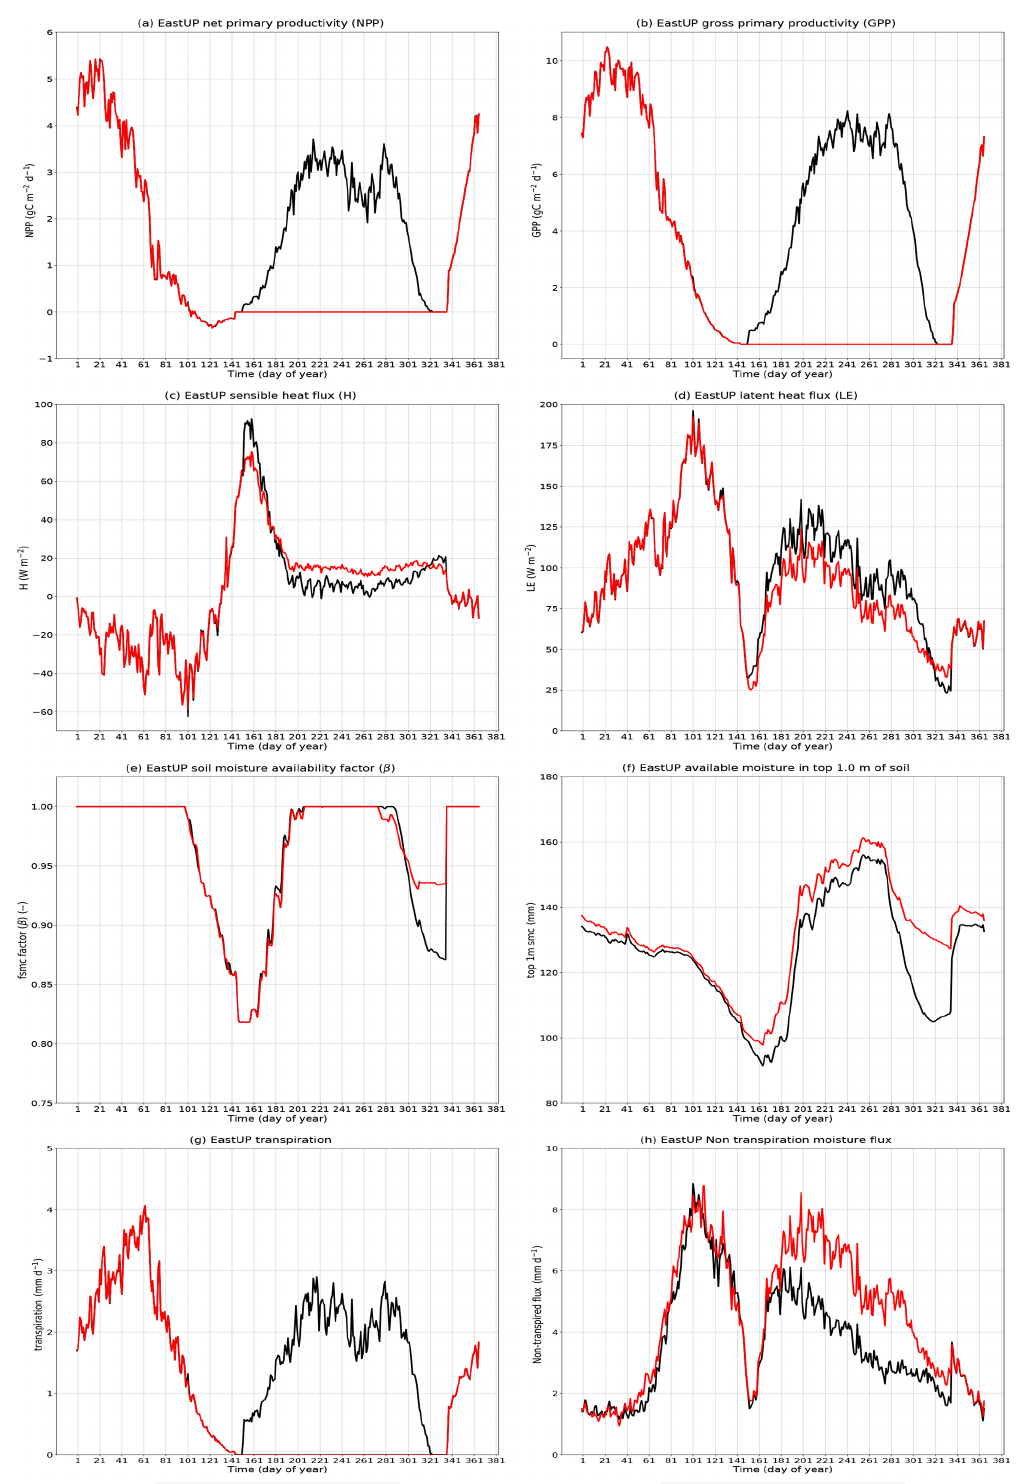
Figure B4. Annual climatology of fluxes (in day of year) for EastUP for India-sequential (black) and India-single (red): carbon fluxes: NPP (a) and GPP (b) . Heat fluxes: sensible heat H (c) and latent heat LE (d) . Soil moisture variables: β (e) and soil moisture availability in the top 1m of soil (f) . Moisture fluxes: evapotranspiration (g) and non-evapotranspiration moisture fluxes (h)